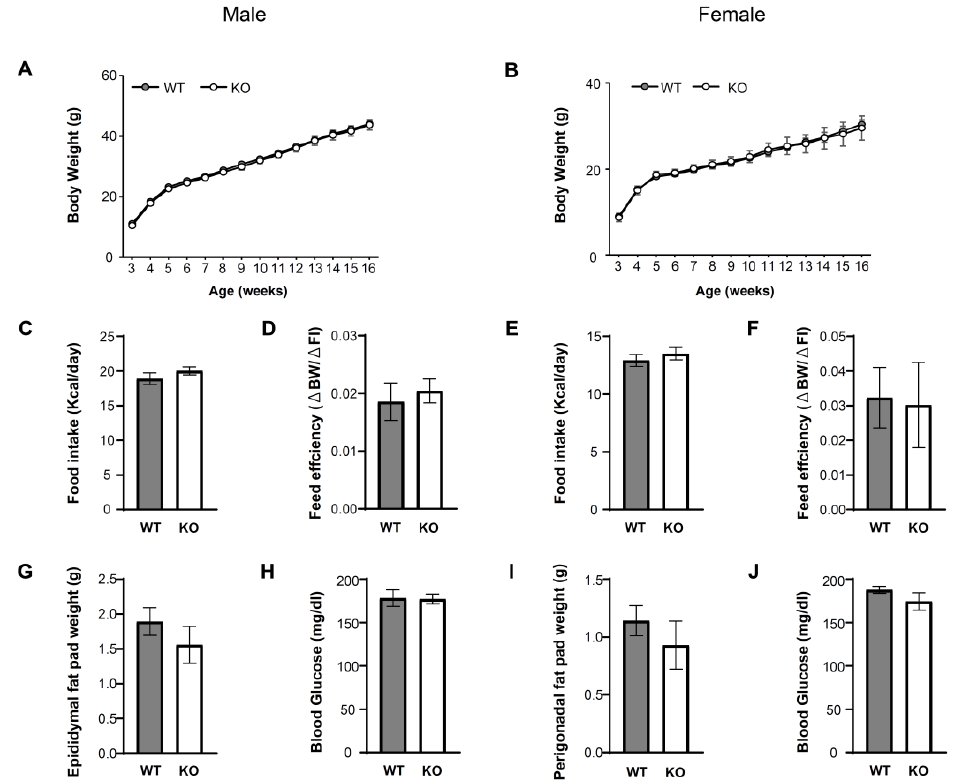
Figure 2. There were no statistically significant differences between WT and KO mice in terms of energy balance after 13 weeks HFD administration. ( A , B ) Body weight of male ( A ) and female ( B ) IKKβ lox/lox (WT) and IKKβ lox/lox DAT-Cre (KO) mice on HFD for 13 weeks. ( C , E ) Daily food intake of male ( C ) and female ( E ) 16-week-old WT and KO mice ( D , F ) feed efficiency of male ( D ) and female ( F ) 16-week-old WT and KO mice ( G , I ) epididymal fat pad weight ( G ) and perigonadal fat pad weight ( I ) 16-week-old WT and KO mice ( H , J ). Blood glucose of male ( H ) and female ( J ) WT and KO mice at the age of 16 weeks. Data are mean ± SEM. Two-way ANOVA with repeated measures was used for statistical analysis of A and B, or an unpaired t test was used for statistical analysis of C to J. The details of statistics are shown in Table S2.